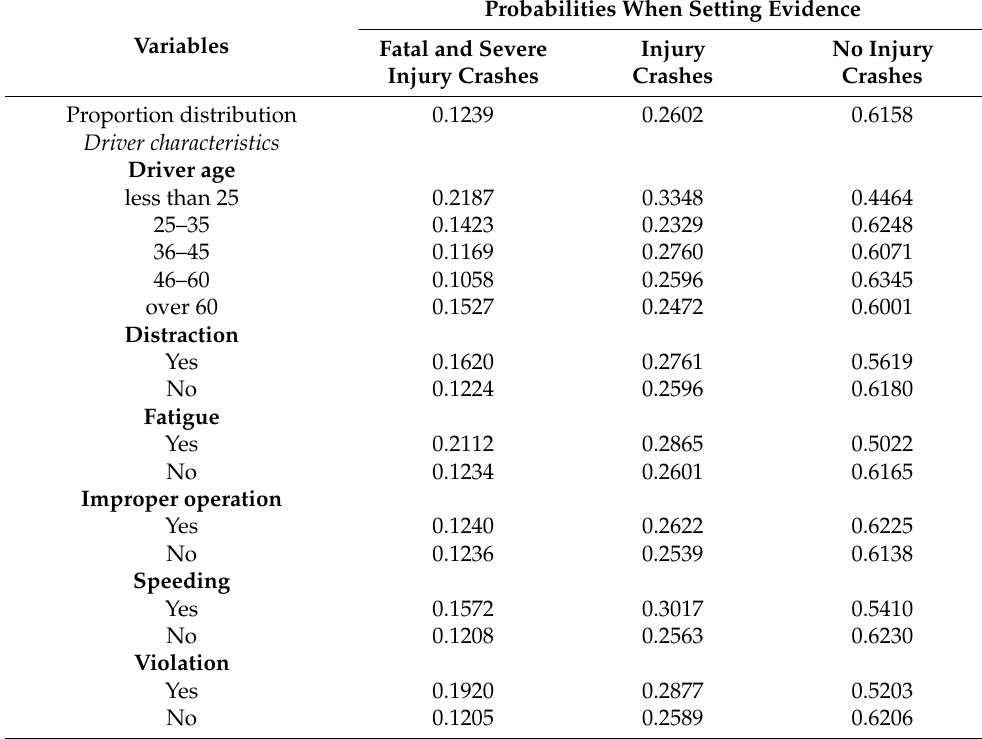
Table 2. Bayesian network probability inference results for HAZMAT road transportation crash